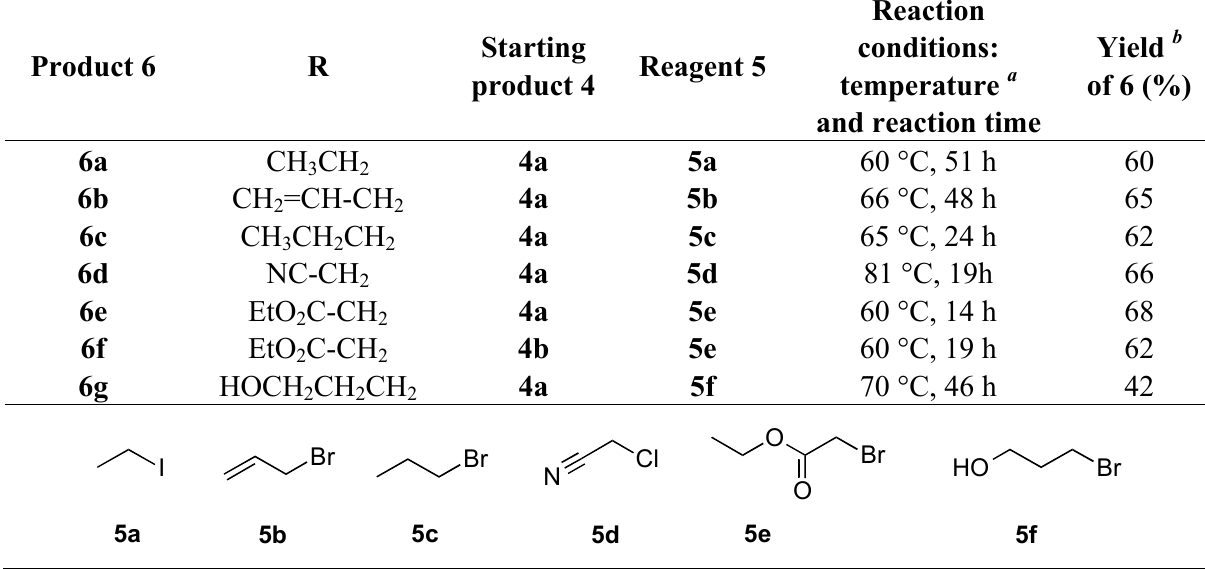
Table 2. Results for the preparation of ( 5Z )-2-alkylthio-5-arylmethylene-1-methyl 1,5- dihydro-4 H -imidazol-4-one 6(a-e) from ( 5Z )-5-arylmethylene-1-methyl-2-thioxo imidazol- in-4-ones 4 and halogeno alkanes 5